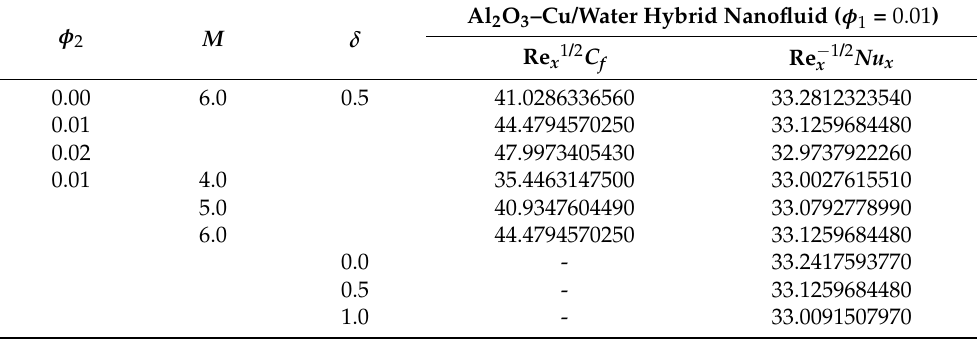
Table 4. Values of Re x 1/2 C f and Re − 1/2 x Nu x for Al 2 O 3 –Cu/water hybrid nanofluid when